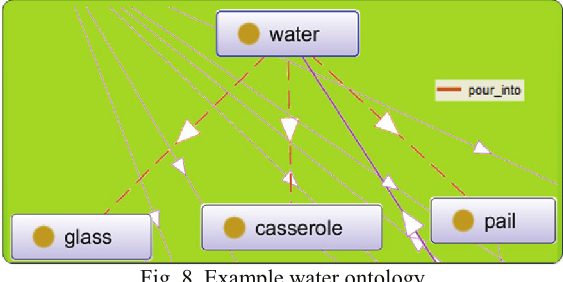
Fig. 8. Example water ontology